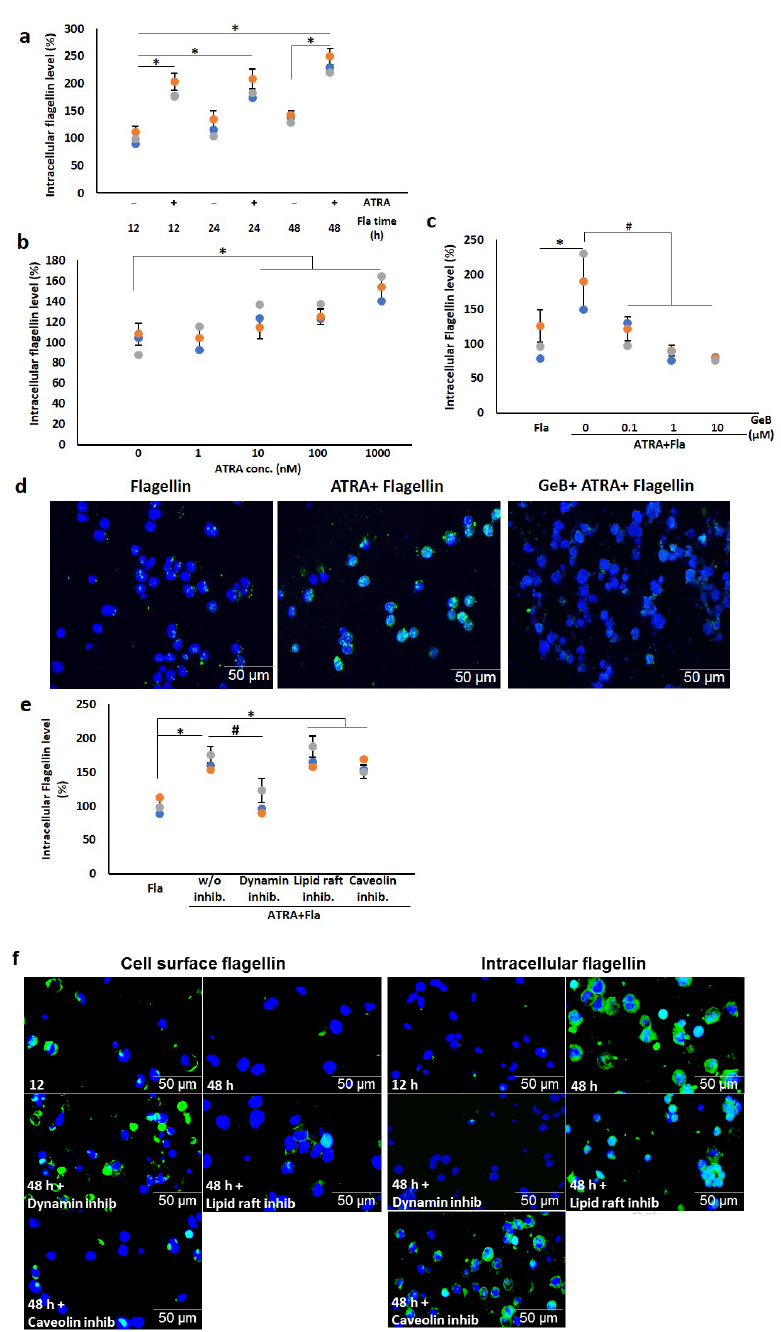
Figure 6. ATRA enhances the Hsp90-mediated flagellin internalization via the clathrin-mediated endocytosis pathway. ( a , b ) Intracellular flagellin levels following treatment with ATRA and flagellin at different exposure times and concentrations of ATRA. THP-1 cells were treated with 1 µM ATRA for 24 h or with DMSO followed by challenge with 100 ng/mL flagellin for different time periods or with various concentrations of ATRA for 24 h before 48 h incubation with 100 ng/mL flagellin. ( c , d ) Intracellular flagellin levels in the presence of specific inhibitor of cell surface Hsp90 (GeB). Cells were exposed to different concentrations of GeB for 2 h prior to stimulation with 1 µM ATRA for 24 h and 100 ng/mL flagellin for 48 h. The intracellular level of flagellin was measured by flow cytometry ( c ) or by confocal microscopy ( d ). After 24 h stimulation with 1 µM ATRA in the presence (right panel) or absence (left and middle panel) of the Hsp90 inhibitor (GeB), the cells were further treated with 100 ng/mL flagellin for 48 h. The collected cells were then fixed with formalde- hyde, permeabilized with Triton X-100 and incubated with the anti-flagellin antibody overnight at 4 °C. After subsequent incubation with the fluorescein isothiocyanate (FITC)-conjugated secondary antibody and Hoechst33342 staining dye for nucleus, the intracellular level of flagellin was detected by confocal microscope (×200). Scale bars represent 50 µm. ( e ) Intracellular flagellin levels in the presence of different endocytosis inhibitors. Cells were stimulated with 1 µM ATRA for 24 h prior to treatment with different endocytosis inhibitors (10 µM dynasore (dynamin inhibitor), 5 mM me- thyl- β cyclodextrin (lipi d raft inhibitor) or 1.5 µM filipin III (caveolin inhibitor)) for 2 h. The cells were further treated with 100 ng/mL flagellin for 48 h. The flagellin levels were measured by flow cytometry. ( f ) Intracellular and cell surface flagellin levels in the presence of different endocytosis inhibitors. Cells were treated with 1 µM ATRA in the presence or absence of different endocytosis inhibitors (1 µM Dyngo ® 4a (dynamin inhibitor), 5 mM methyl- β cyclo dextrin (lipid raft inhibitor) or 1.5 µM filipin III (caveolin inhibitor)) for 2 h, followed by the treatment with 100 ng/mL flagellin for 1 h or 48 h. The intracellular (right panel) or cell surface flagellin levels (left panel) were meas- ured by fluorescence microscopy (×200). Green, flagellin; blue, nuclei. * p < 0.05; # p < 0.05. 3.7. αMβ2 Integrin Acts as a Carrier for Bacterial Flagellin Internalization Along with the identification of integrin αMβ2 as a new interacting partner of cell surface Hsp90, the observation that cell surface Hsp90 is associated with the uptake of flagellin brings us to the hypothesis that integrin αMβ2 is also involved in the internali- zation of flagellin. To clarify this speculation, we first examined the expression of integrin αMβ2 by the treatment of ATRA and flagellin. As depicted in Figure 7a–d (Supplementary Figure S7) , the induction of cell surface integrin αMβ2 by ATRA was further enhanced by flagellin treatment, indicating a close correlation between flagellin recognition and integ- rin activation. A 48 h treatment with flagellin led to a low level of cell surface Hsp90- bound integrin αMβ2, which was reversed in the presence of dynamin inhibitor Dyngo® 4a, indicating the internalization of integrin αMβ2 through a dynamin -dependent way in the presence of flagellin. Furthermore, by blocking αM integrin using the blocking mono- clonal antibody CD11b/Mac-1 (ICRF44), we found a suppressed level of intracellular